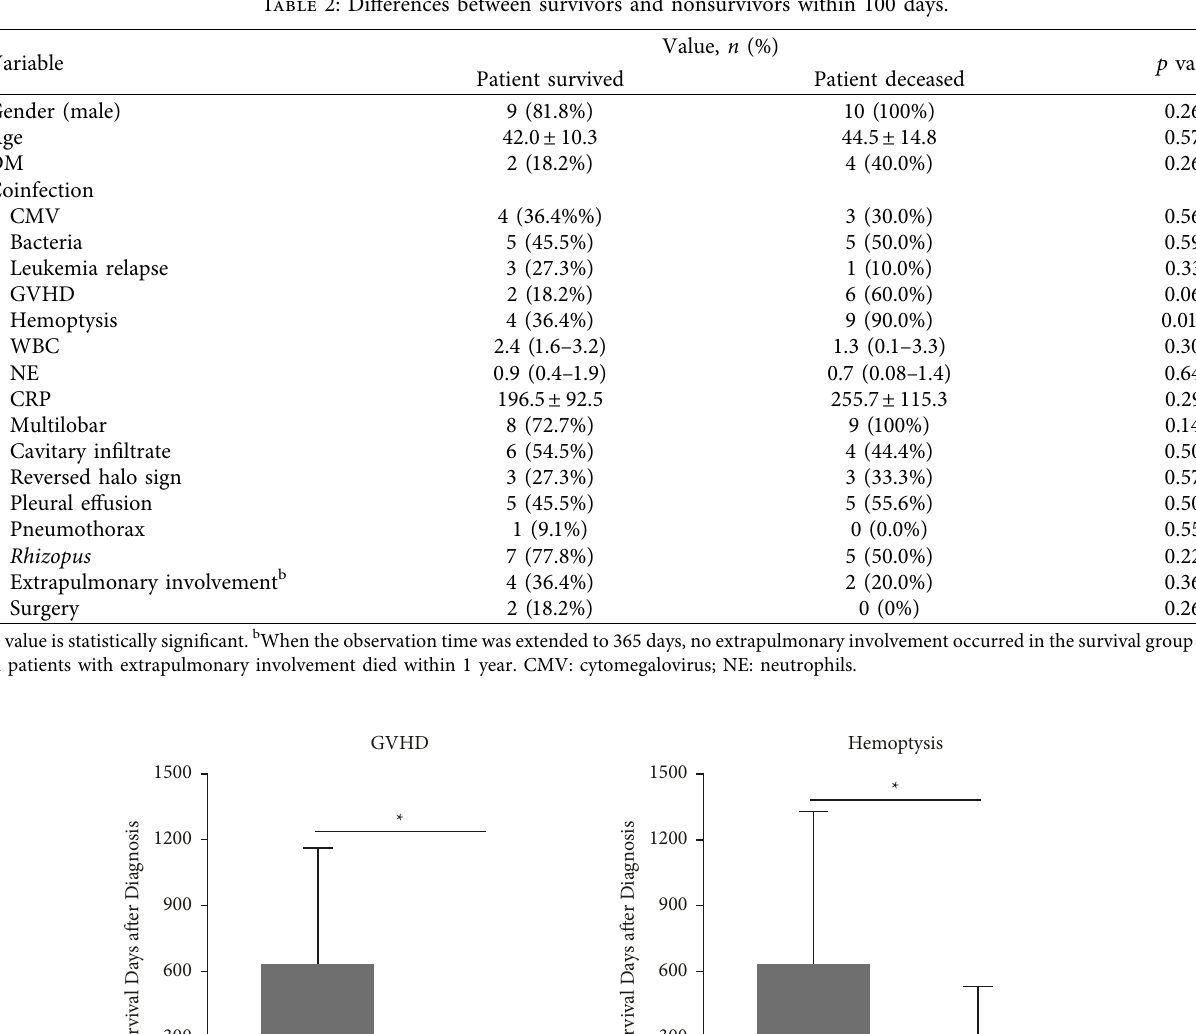
Table 2: Differences between survivors and nonsurvivors within 100 days.